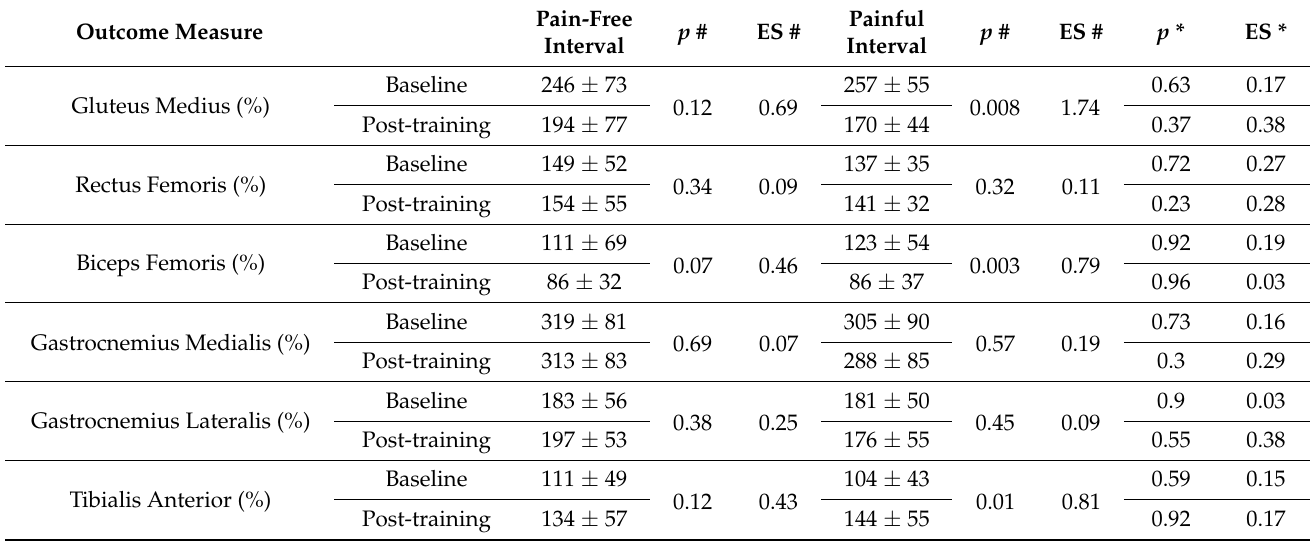
Table 2. Comparison of mean amplitude range of the sEMG signal between minimal and maximal value in pain-free and in painful intervals of the treadmill